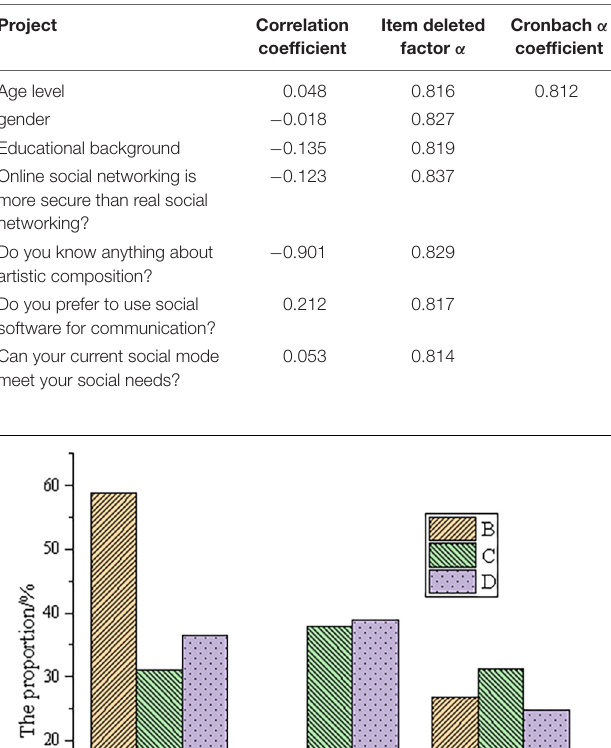
TABLE 1 | Questionnaire reliability analysis of social factors.